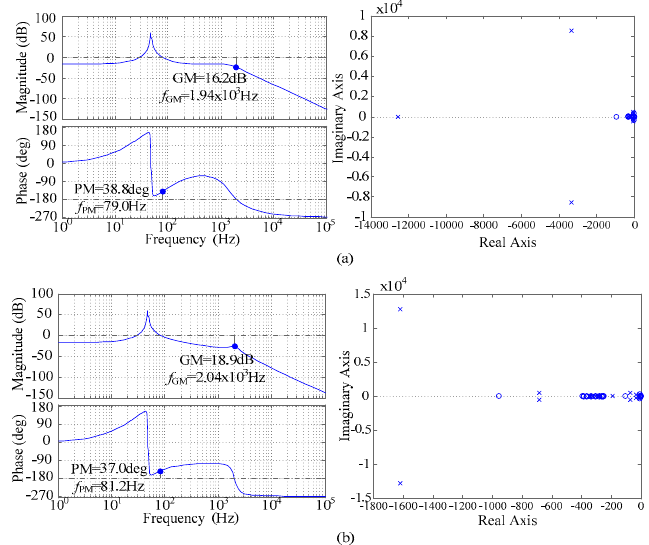
Figure 10. The open-loop Bode diagrams and closed-loop pole-zero diagrams of the equivalent coefficient of current source G j eq for single inverter in different cases. ( a ) Case I; ( b ) Case II.